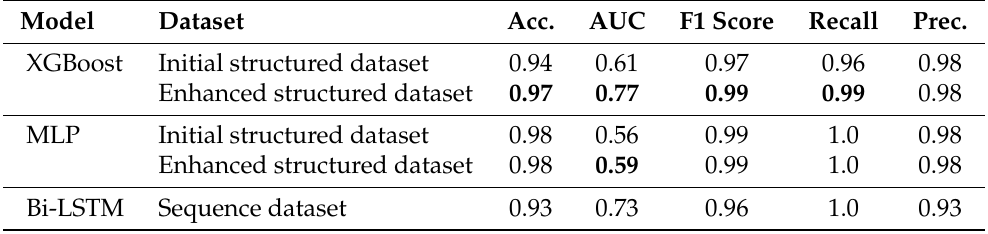
Table 2. Performance measures. We report accuracy (Acc.), area under the curve (AUC), F1 score, recall, and precision (Prec.) for the named models and datasets. To compare the performance of the models using the initial or enhanced structured datasets, superior values are shown in bold. (for confusion matrices see Additional file